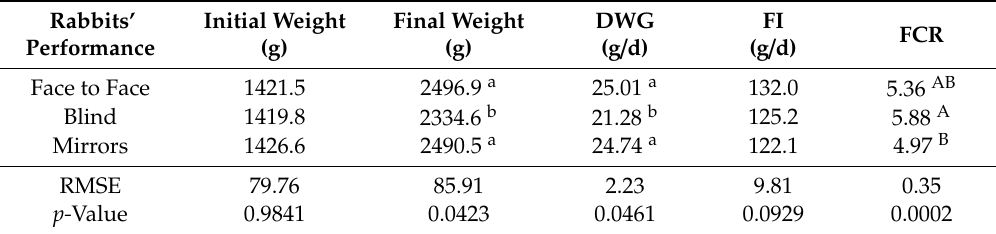
Table 2. E ff ect of raising system on growth performance of rabbits.